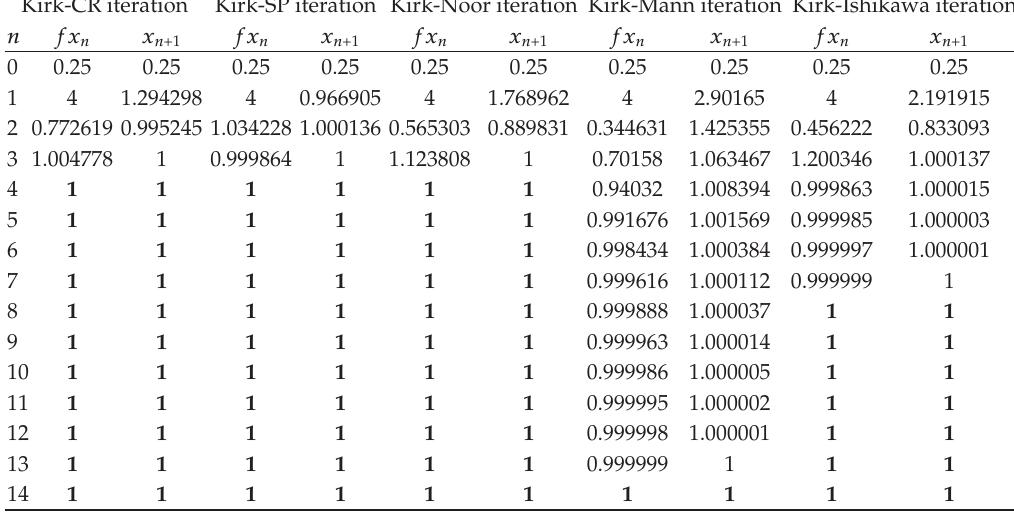
Table 5: Oscillatory